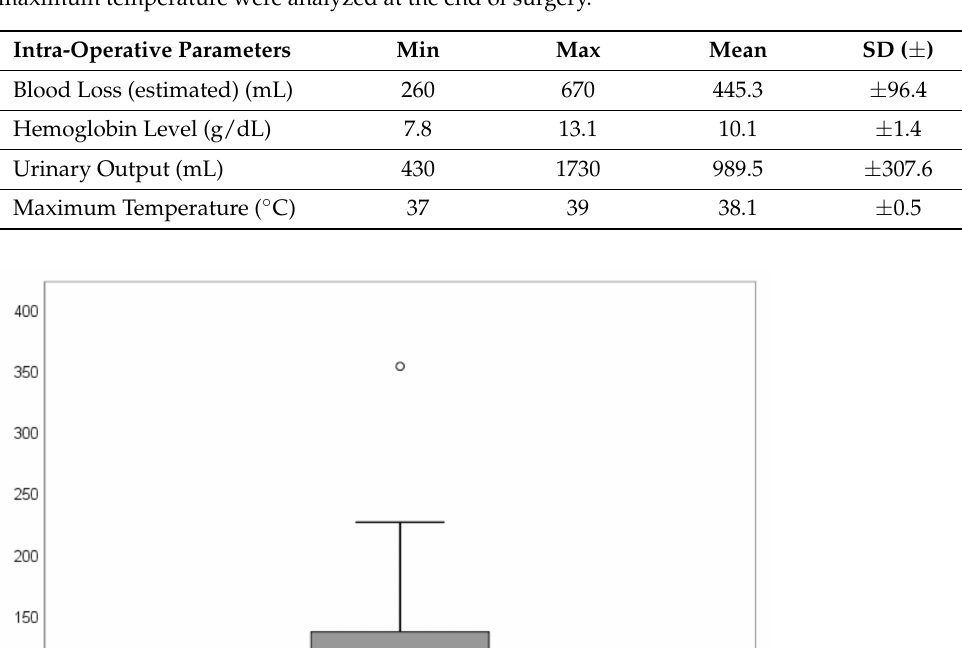
Table 2. Numerical analysis of intra-operative parameters ( n = 122) (mL: Milliliter, g/dL: gram per deciliter, ◦ C: Celsius Degree, Min: Minimum, Max: Maximum). Note: Hemoglobin level and maximum temperature were analyzed at the end of surgery.